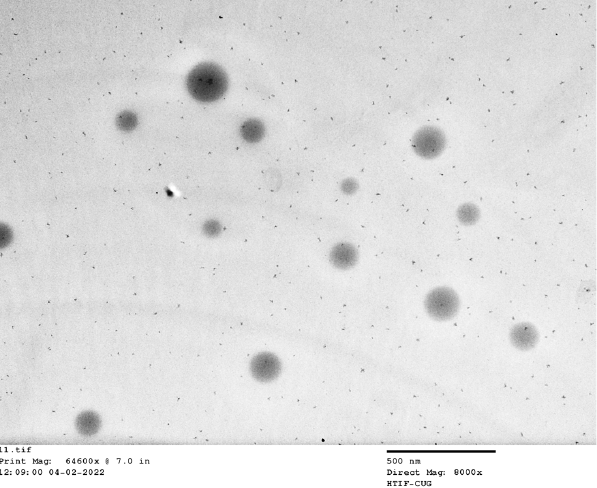
Figure 8. A representative transmission electron microscopy image of levosulpiride niosomes (NC).